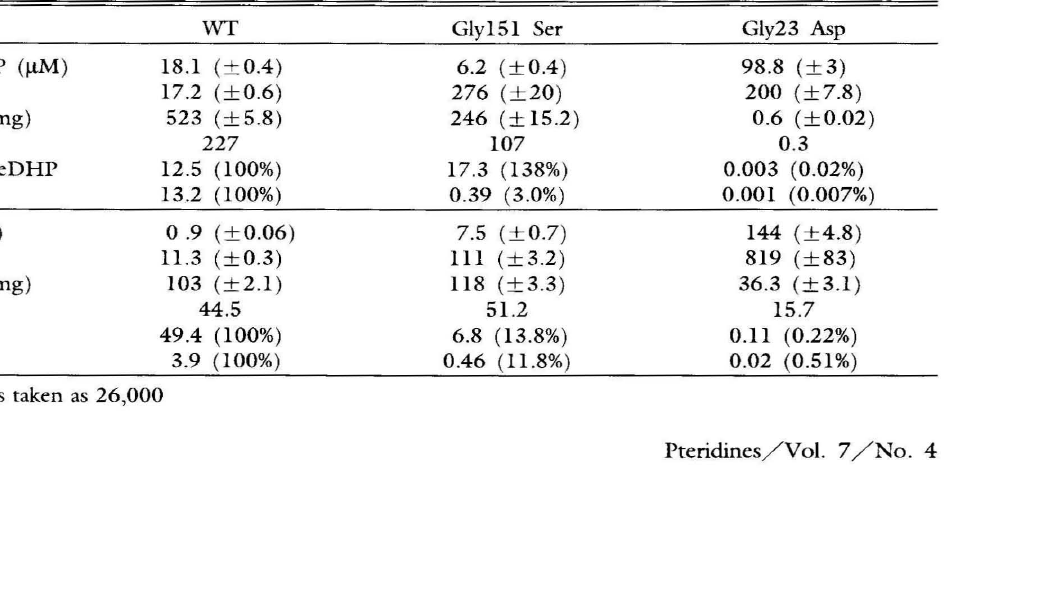
Figure S. Kinetic parameters of GST-DHPR mutants at residue ISO of DHPR (WT has TyrlSO, the second sub strate is in brackets). Table 4. Kinetic parameters of mutated DHPRs* in PKU patients. 0.1 M Tris-HCI buffer pH 7.4, at 2SoC